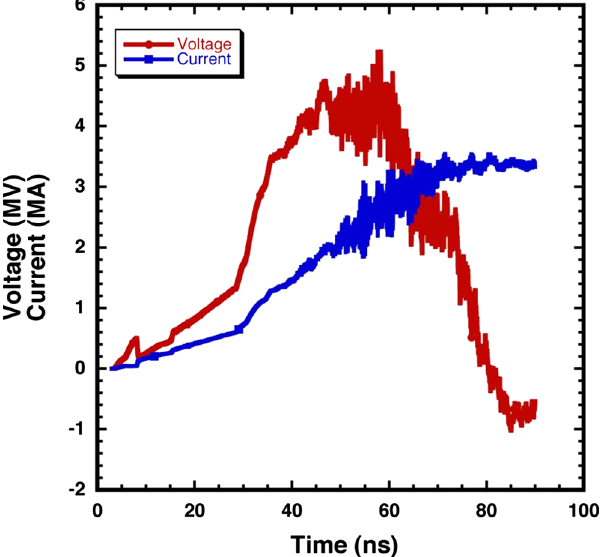
FIG. 5. (Color) Inlet voltage and current for the high-voltage simulation. The oscillations starting at 50 ns are due to electron instability as electron drift velocity slows due to stable or falling voltage and increasing currents. The vacuum-flowing electron current at 55 ns is 65 kA, or 4.3% of the total current at that